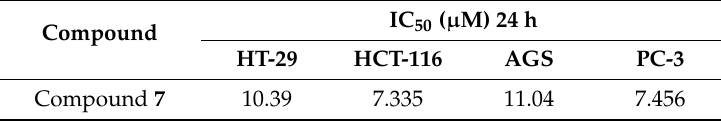
Table 1. Cytotoxic activity of compound 7 . IC 50 values for each cell line were calculated by using GraphPad Prism 7.